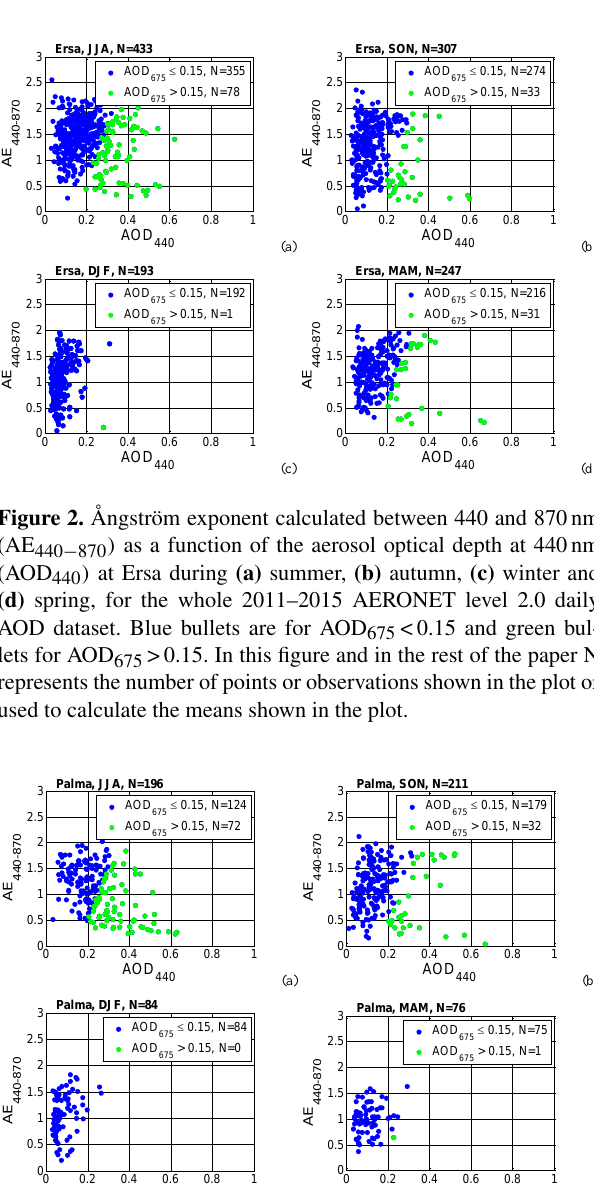
Fig. 5 for Palma. As expected from the above discussion the criteria AOD 675 > 0.15 removes a lot of points (the number of remaining points per season is lower than 78) and makes the database unexploitable in winter ( N = 1 at Ersa and N = 0 at Palma). As discussed further in this section, the statistics in spring at Palma ( N = 1 for AOD 675 > 0.15) are not